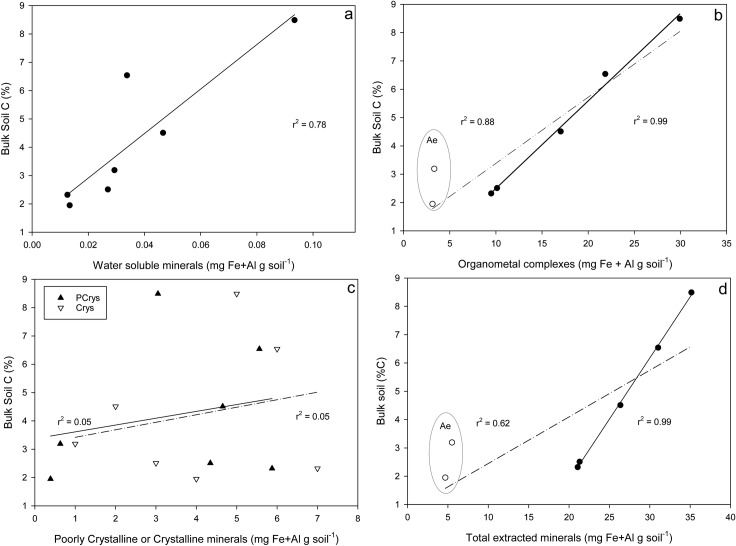
Relationship between bulk soil C (%C) and the sum of Fe and Al for a) water soluble; b) organometal complexes; c) poorly-crystalline (dark triangles) or crystalline minerals (white triangles); d) total extracted mineral pools. Data for both Mature and Young sites are combined, and the difference between Al (white symbols and hatched regression lines) and Fe (dark symbols and solid regression lines) are highlighted in b) and d). Data from A$_e$ horizons are indicated in b) and d).